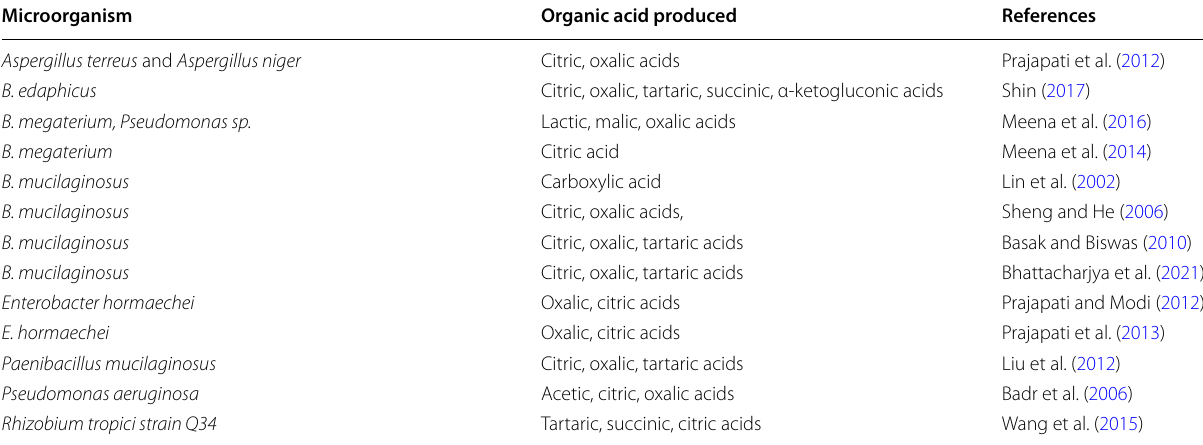
Table 1 Some potassium solubilizing microorganisms and their excreted organic acids